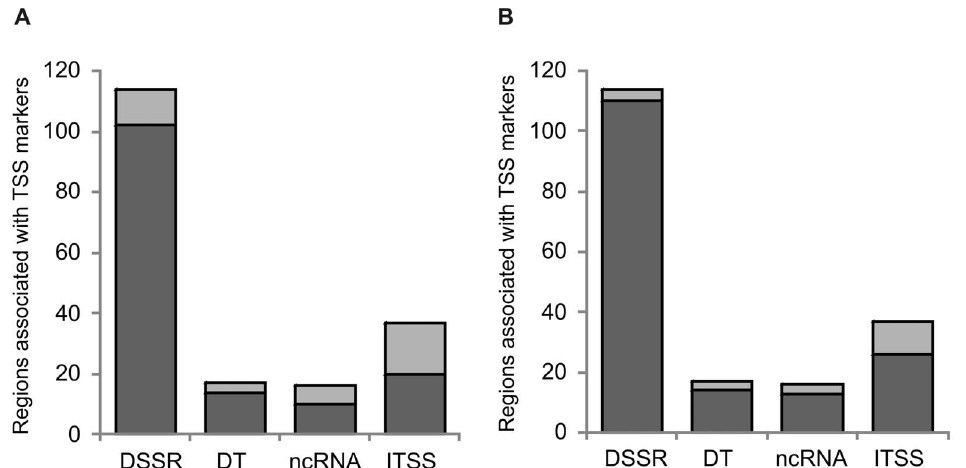
Figure 6. Comparative analysis of high RIIC regions vs. reported putative TSS in Leishmania . A . The total number of different type of regions (D SS: Divergent Strand Switch; D T: divergent telomeres; ncRNA: associated with ncRNA transcription; I TSS: internal to polycistrons TSS) associated with TSS markers obtained in Thomas, et. al . [18] in the L. major genome is represented. Dark grey indicates the number of regions associated with TSS markers that overlap with high RIIC regions. B . Same as in A displaying in dark grey the number of regions associated with TSS markers that overlap with high RIIC regions that are present either in L. major or L. infantum .